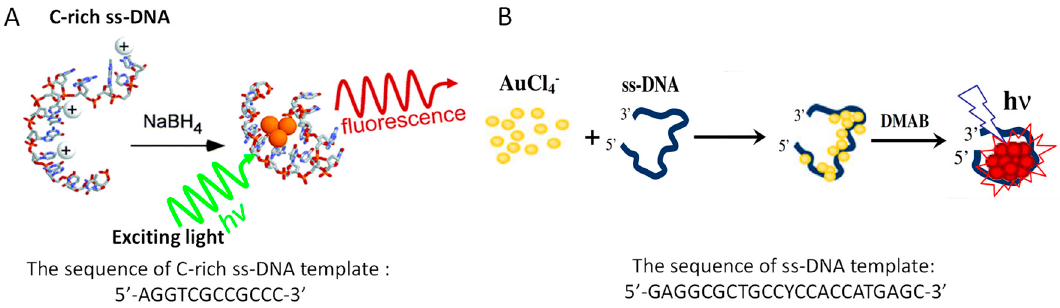
Figure 2. Schematic illustration of ( A ) DNA-templated AgNCs. Reprinted with permission from Ref. [14]. T Copyright 2004, American Chemical Society. ( B ) DNA-templated AuNCs. Reprinted with